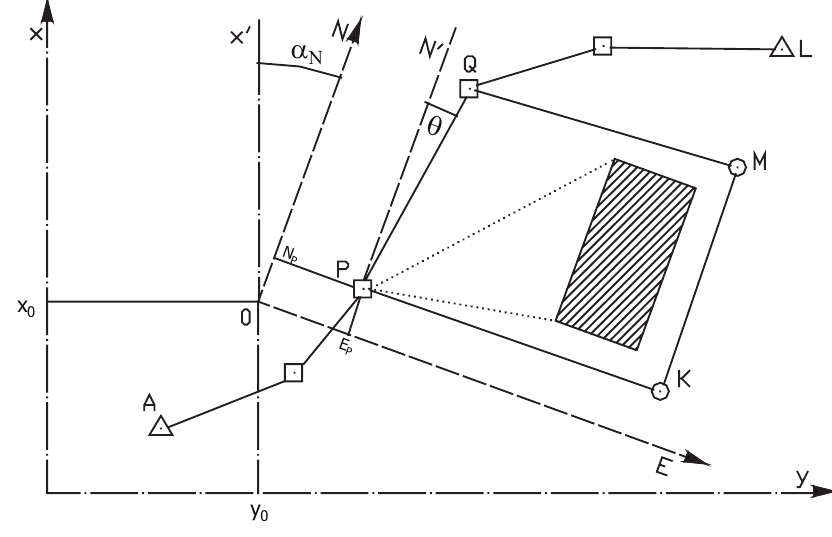
Fig. 3. Connecting building site network by means of a connecting traverse in case it is used as a non-parallel site grid coordinate system (N,